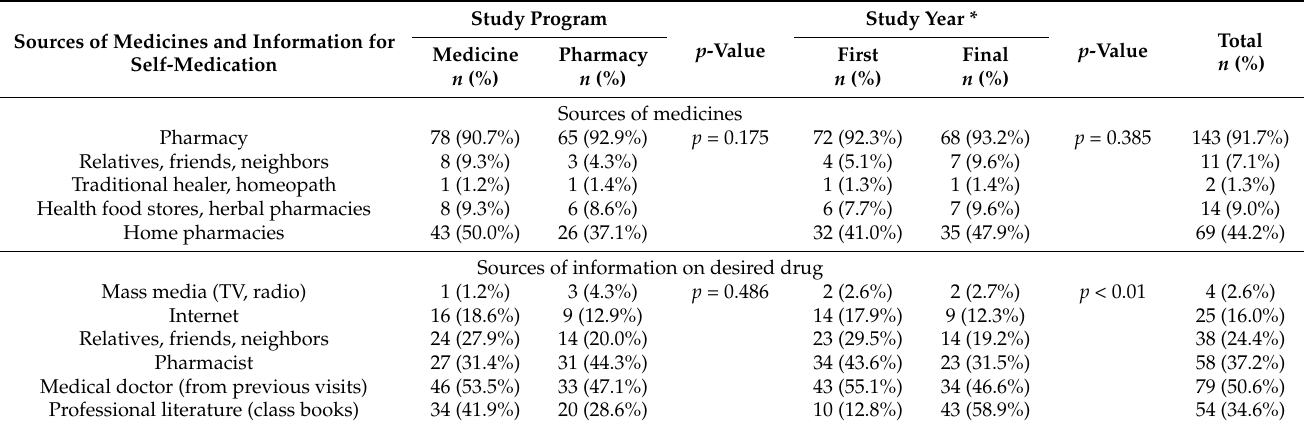
Table 3. Sources of medicines used for self-medication and information regarding the choice and proper